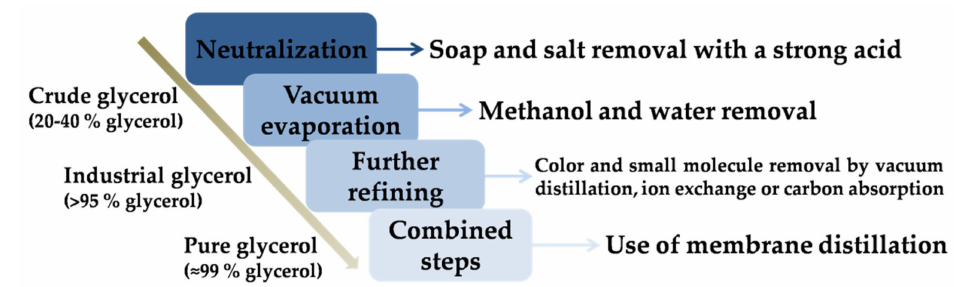
Figure 4. Purification stages from crude to pure